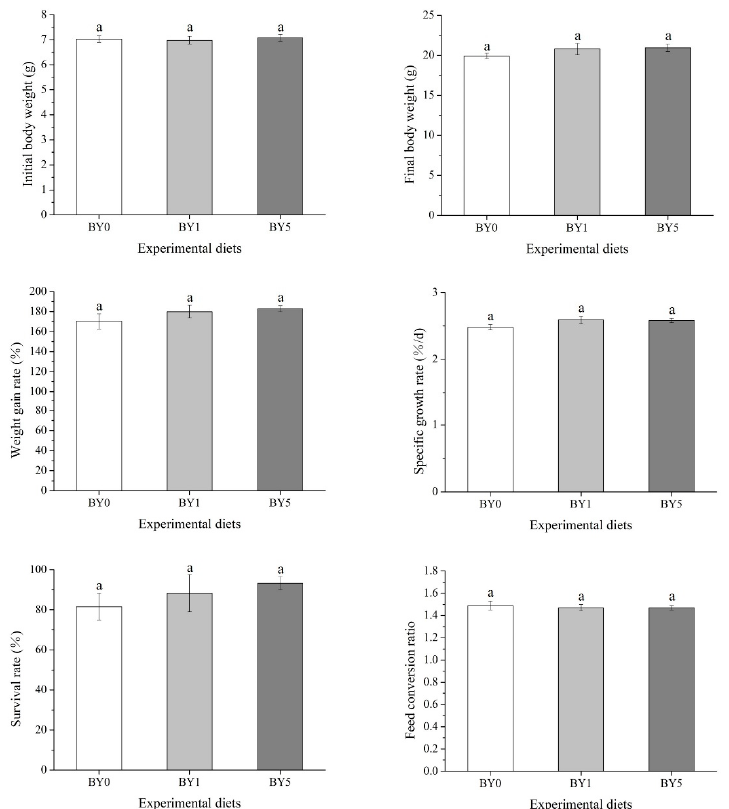
Figure 2. Effects of dietary Barranca yajiagengensis powder supplementation on growth performance and feed utilization of T. ovatus after 42 day feeding trial. The same letters indicate no significant differences ( p > 0.05). Table 2. Serum parameters of Trachinotus ovatus fed experimental diets for 42 days.